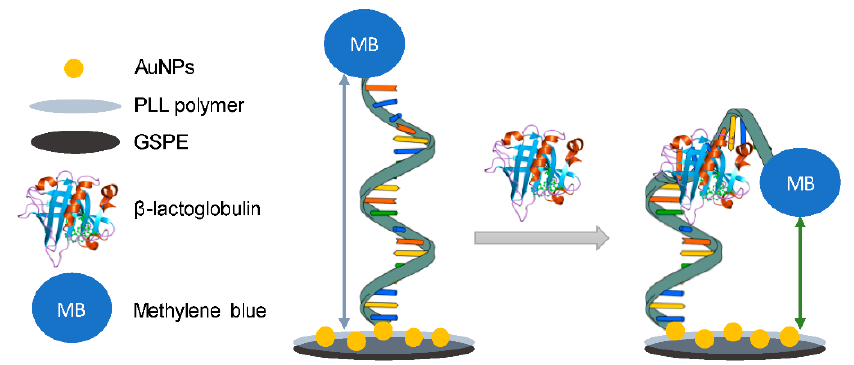
Figure 13. Schematic representation of the sensing strategy of the aptasensor to determine b-lacto- globulin